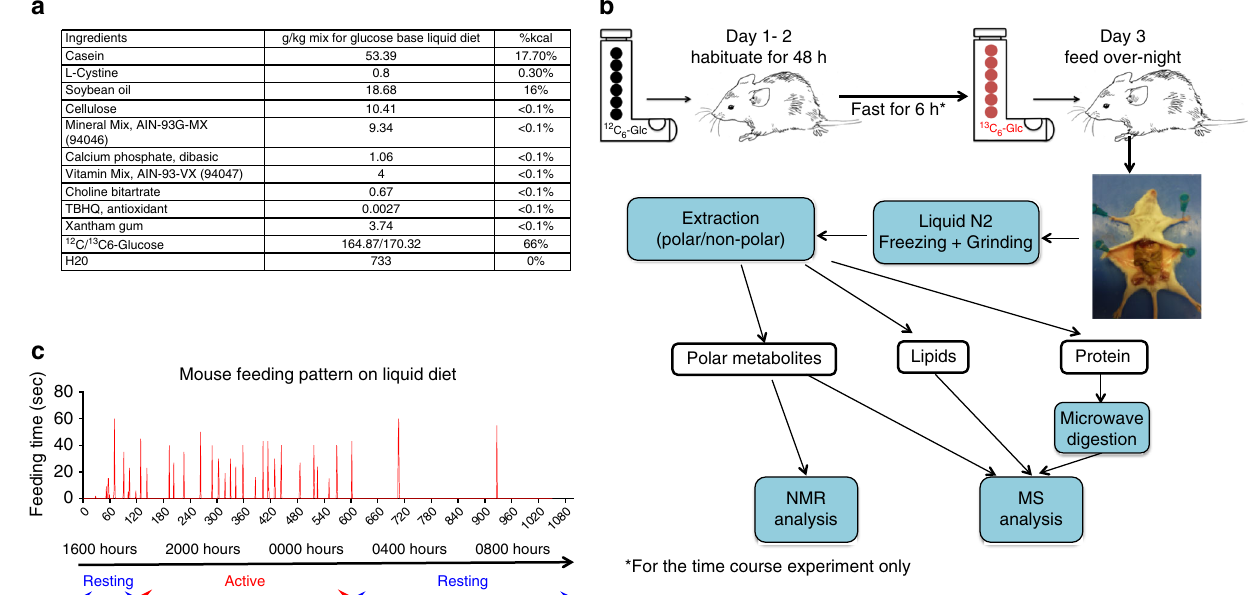
Fig. 1 Procedure for tracing glucose metabolism in vivo. a Composition of liquid diet used for 13 C 6 -glucose tracer feeding (presented as g/kg and %kcal for each ingredient). The constituted liquid diet provides ca. 1000 kcal/l and a 20 g mouse is expected to consume 12.6 kcal a day. b Experimental work fl ow for tracking glucose metabolism in vivo. Mice were fed ad libitum 13 C 6 -glucose enriched diet for 18 h, after which blood was collected, and organs were dissected, snap frozen and pulverized in liquid nitrogen. Samples were then extracted into three fractions: polar, protein, and lipids. Each fraction was analyzed by NMR and/or Mass Spectrometry as described in the Methods. c Feeding pattern of an NSG mouse over 18